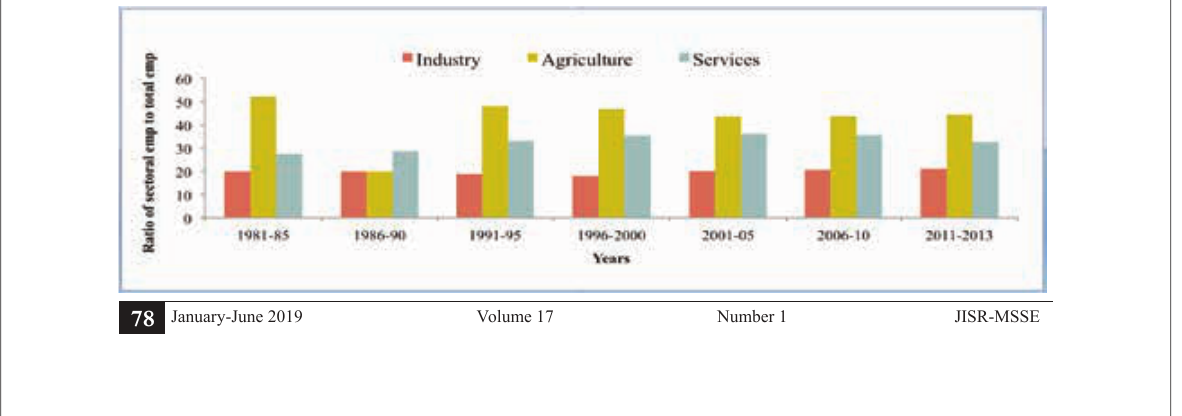
Figure 5: Trend of Sectoral Employment